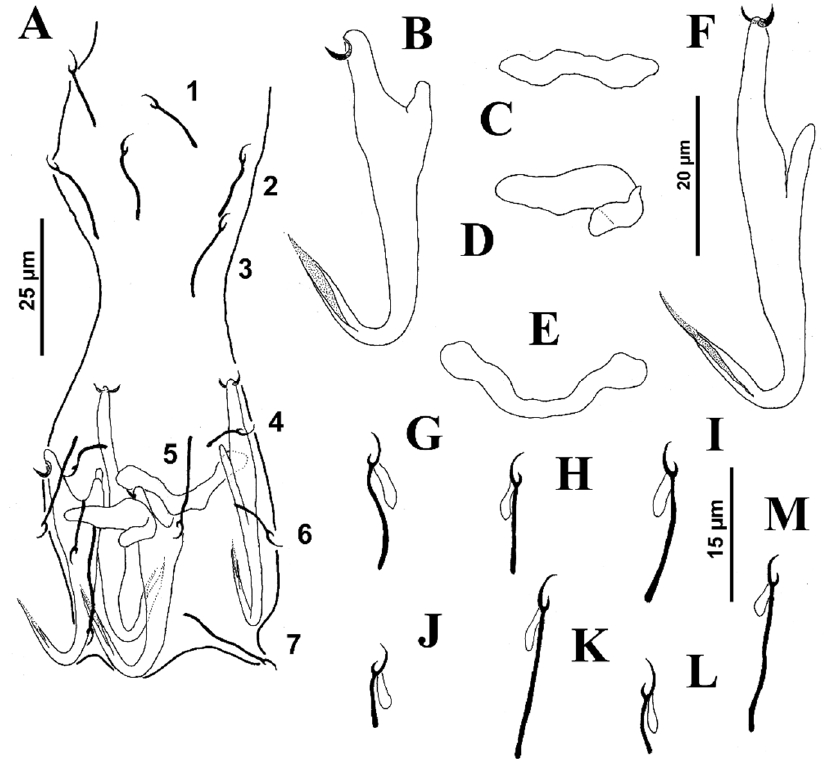
Figure 6. Haptoral structures of Neohaliotrema bifidum n. sp. from the Sergeant-major Abudefduf saxatilis ( A ) Haptor (ventral view) showing positions of hook pairs (1–7) ( B ) Ventral anchor ( C , D ) Ventral anchors ( E ) Dorsal anchor ( F ) Dorsal anchor ( G – M ) Hook pairs 1–7, respectively.